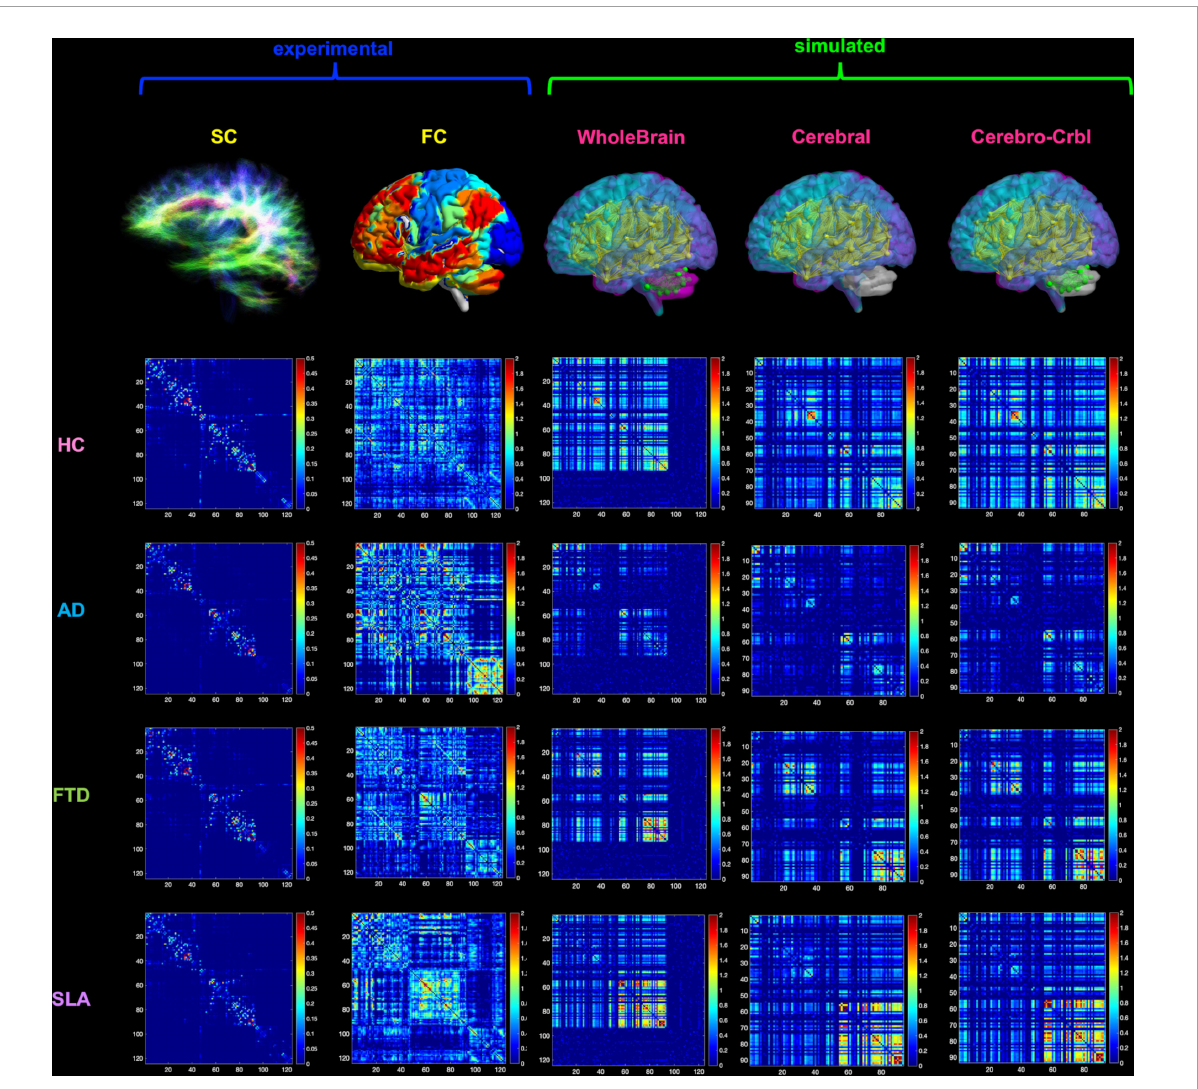
FIGURE2 Networks connectivity matrices. Columns 1 and 2 show the experimental structural (SC) and functional connectivity (FC) matrices, which were used as input for TVB simulations in four different groups: healthy (HC), Alzheimer’s Disease (AD), Frontotemporal Dementia (FTD), and Amyotrophic Lateral Sclerosis (ALS). For each group, matrices of a randomly chosen subject are reported as an example. Columns 3–5 show the simulated FC obtained at single-subject level with three different networks: whole-brain, cortical subnetwork (Cerebral) and embedded cerebro-cerebellar subnetwork (Cerebro-Crbl). In the whole-brain network simulations were performed using whole-brain nodes and connections (whole-brain nodes and edges are colored); in the cortical subnetwork only cerebral cortex nodes and connections were considered (cortical nodes and edges are colored); in the embedded cerebro-cerebellar subnetwork cerebral cortex nodes were considered taking into account the influence of cerebro-cerebellar connections (cortical nodes and cerebellar edges are